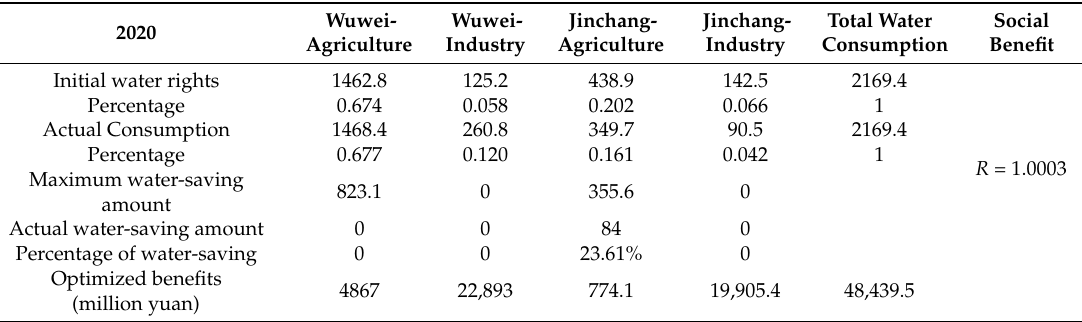
Table 11. Optimized water consumption and benefits for planning year 2020 (million m 3